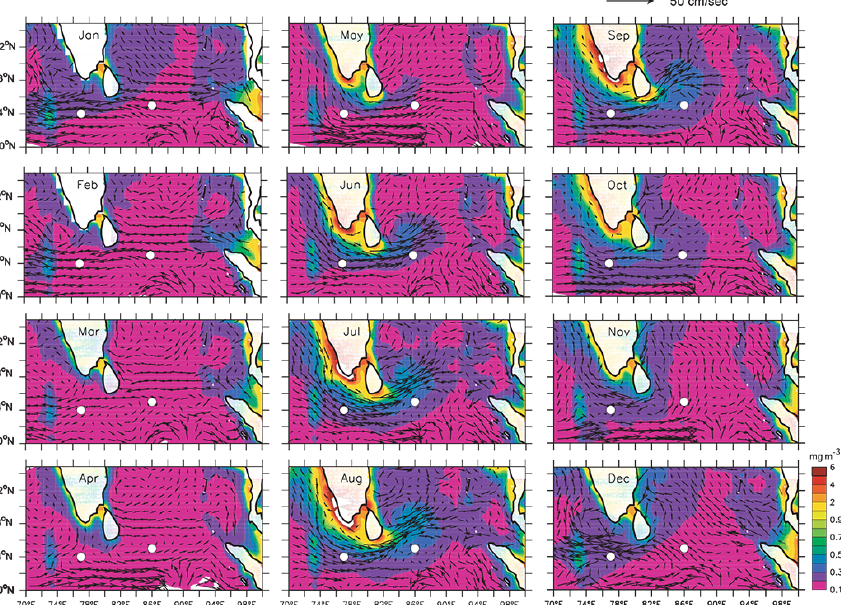
Fig. 10. Monthly mean climatology (1997–2010) of chlorophyll pigment concentration (mgm − 3 ) (shading) overlaid with OSCAR current (arrows), white circles represent location of SBBT and